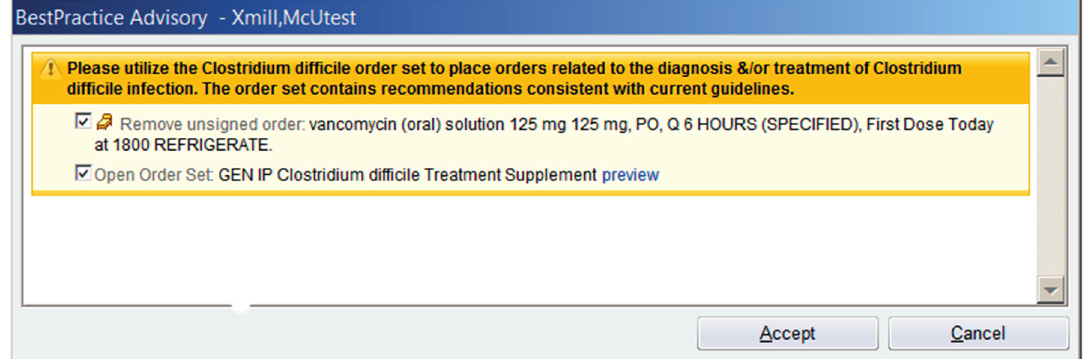
Figure 1. Clostridium difficile Best Practice Alert. © 2015 Epic Systems Corporation.